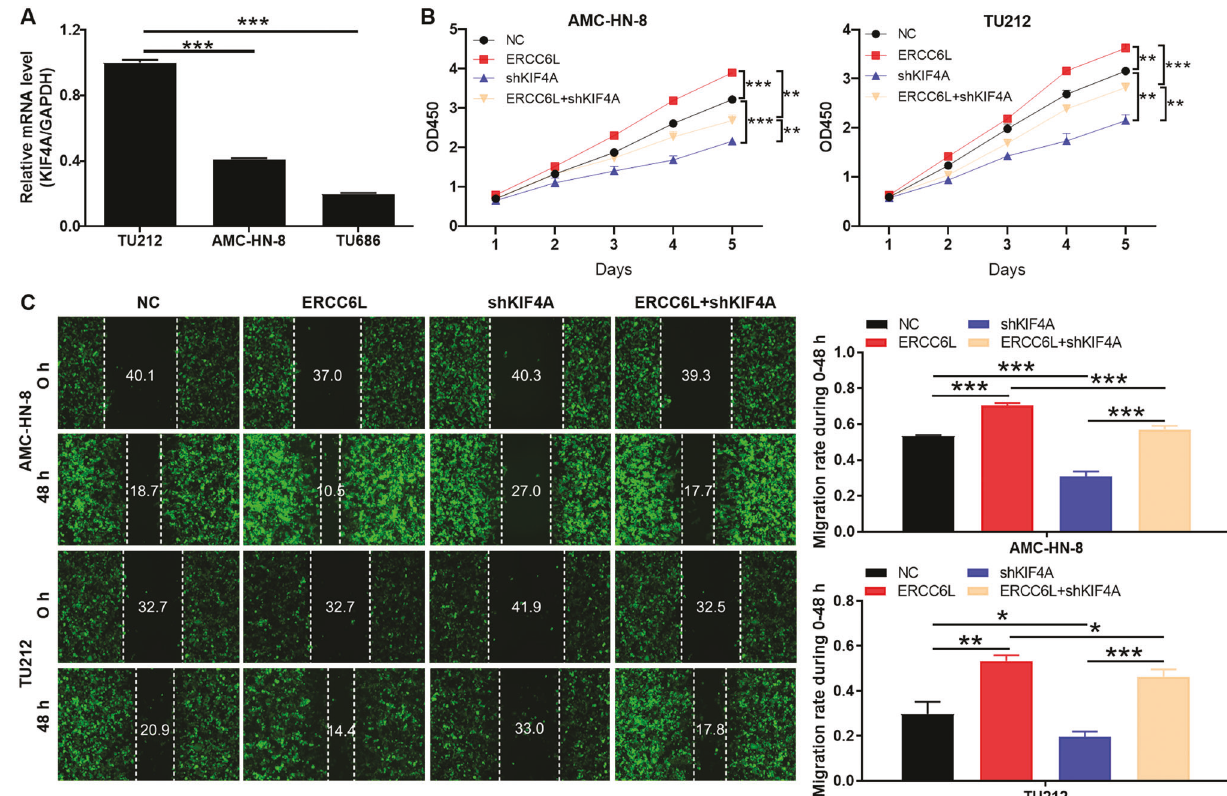
Fig. 4 ERCC6L drives LSCC progression dependent on the presence of KIF4A. A The mRNA expression of KIF4A in LSCC cells such as TU686, TU212, and AMC ‐ HN ‐ 8 was detected using qPCR. B , C ERCC6L overexpression and KIF4A knockdown were separately constructed in AMC-HN- 8 and TU212 cells for loss/gain function assays. The cells models were subjected to the ( B ) MTT assay and ( C ) wound-healing assay. The representative images were selected from at least three independent experiments. Data was shown as mean ± SD. * P < 0.05, ** P < 0.01, *** P <